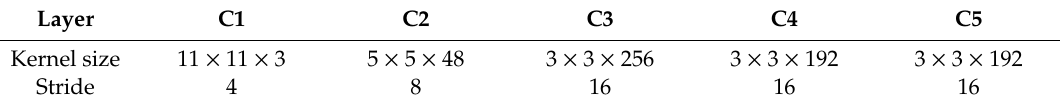
Table 3. Kernel sizes and strides in our Siamese network.